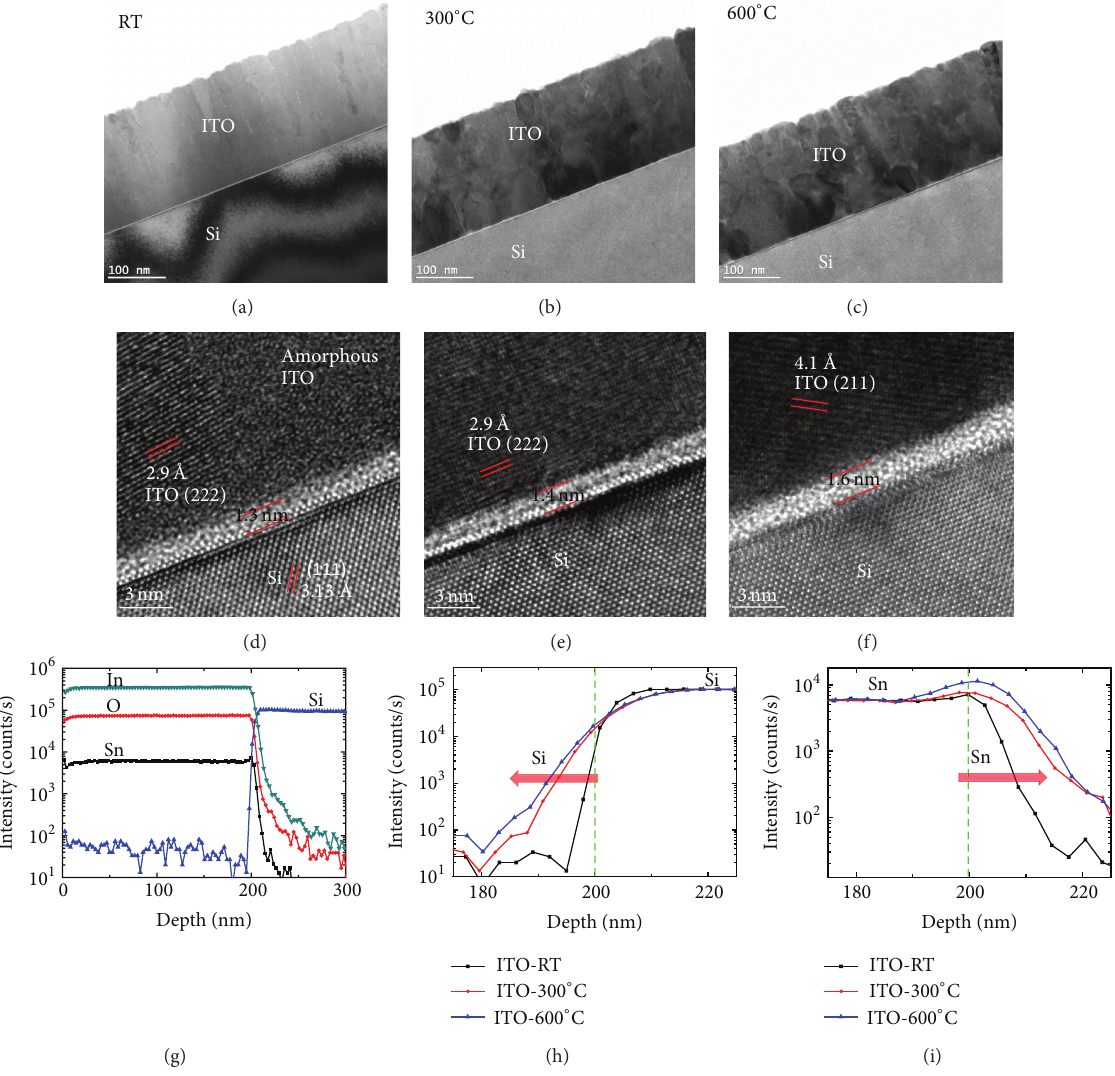
Figure 13: (a)–(c) Low-resolution TEM images of ITO-RT, ITO-300 ∘ C, and ITO-600 ∘ C samples. (d)–(f) High-resolution TEM images of ITO-RT, ITO-300 ∘ C, and ITO-600 ∘ C samples. (g)–(i) Depth profiles of prepared samples (g) for ITO-RT, (h) showing Si signals, and (i) showing Sn signals of ITO-RT, ITO-300 ∘ C, and ITO-600 ∘ C samples [4].